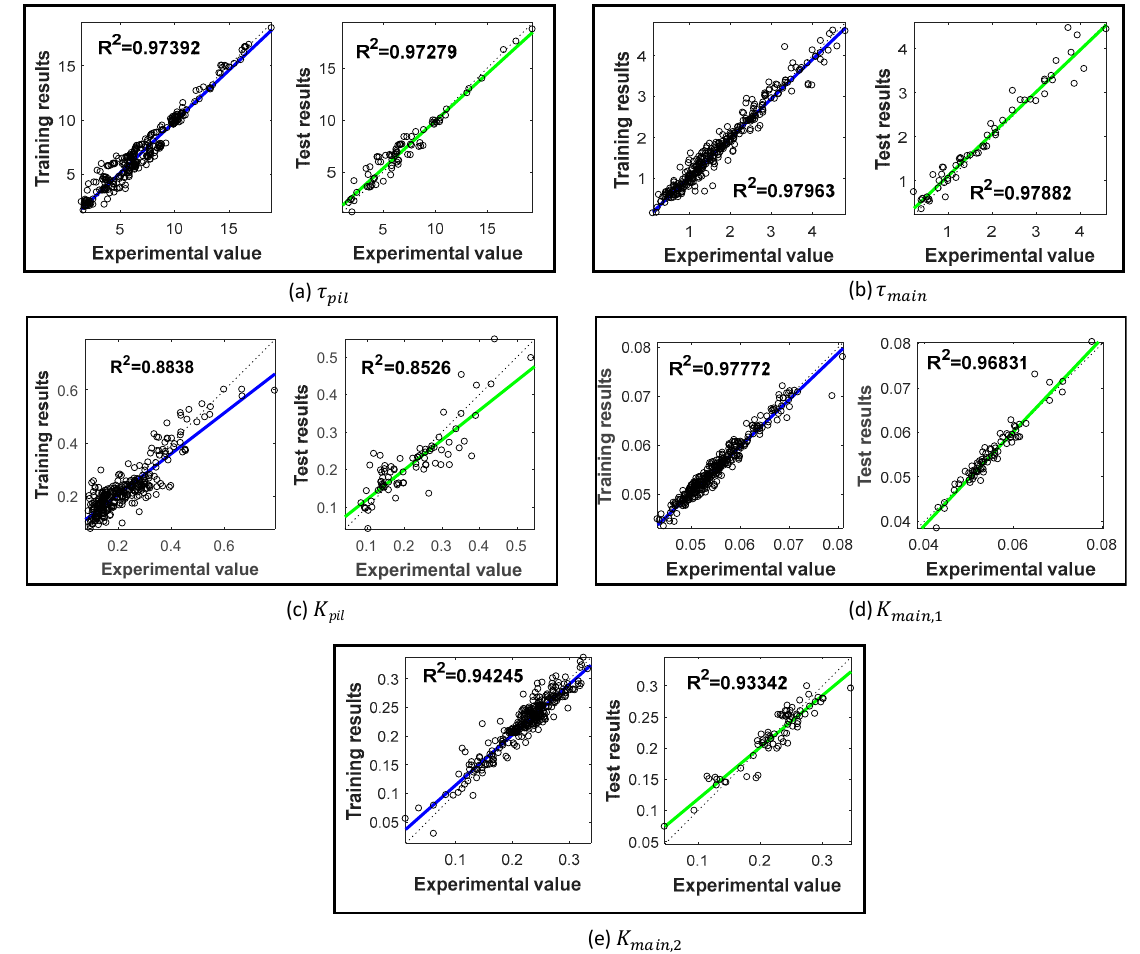
Figure A7. ( a – e ) Comparison of the experimental and ANN fitting results for the physics-based model parameters (heat release simulation).